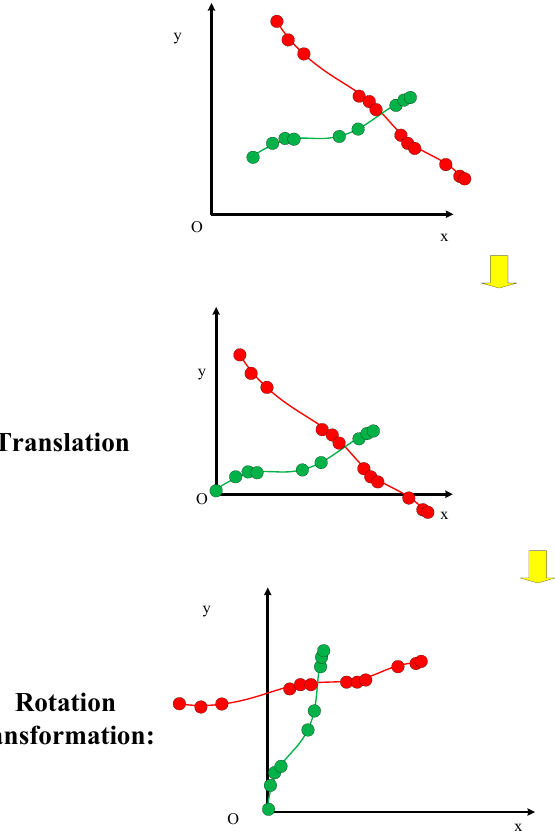
Figure 13. Schematic of the proposed translation and rotation transformation.